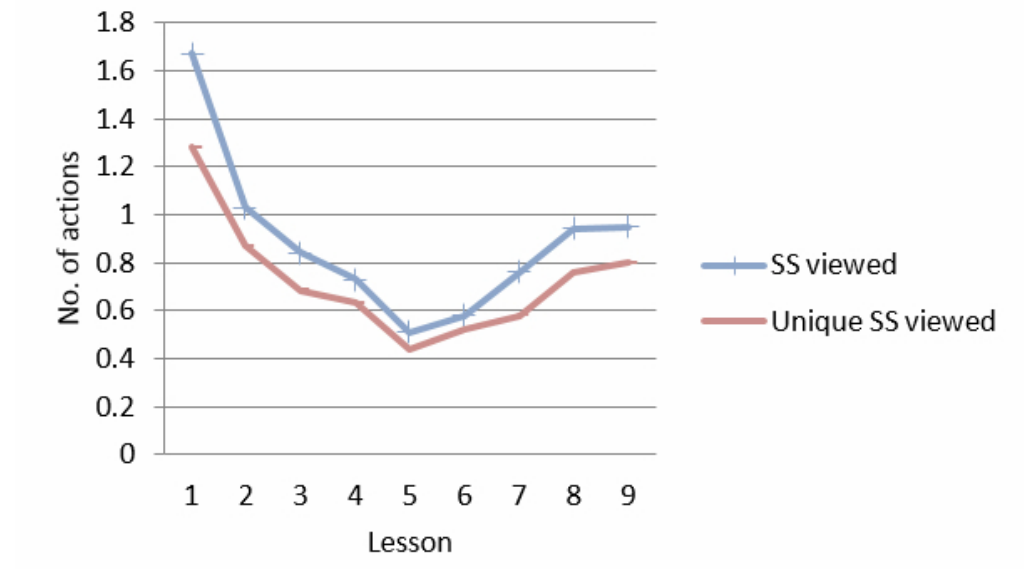
Figure 4. Success stories per lesson.